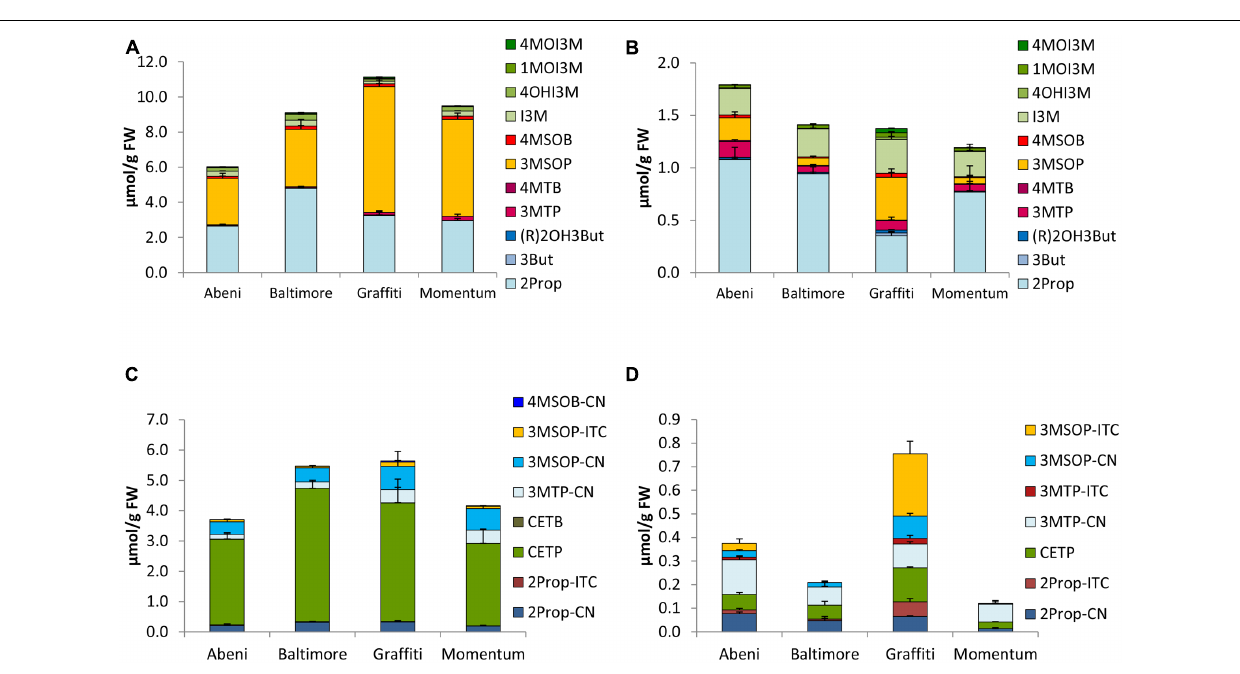
(4MSOB-CN), 2PE-CN, IAN, 4-methoxy-3-indoleacetonitrile (4MOIAN), and 1-methoxy-3-indoleacetonitrile (1MOIAN)], seven ITCs [2Prop-ITC, 3But-ITC, 3MTP-ITC, 4MTB-ITC,